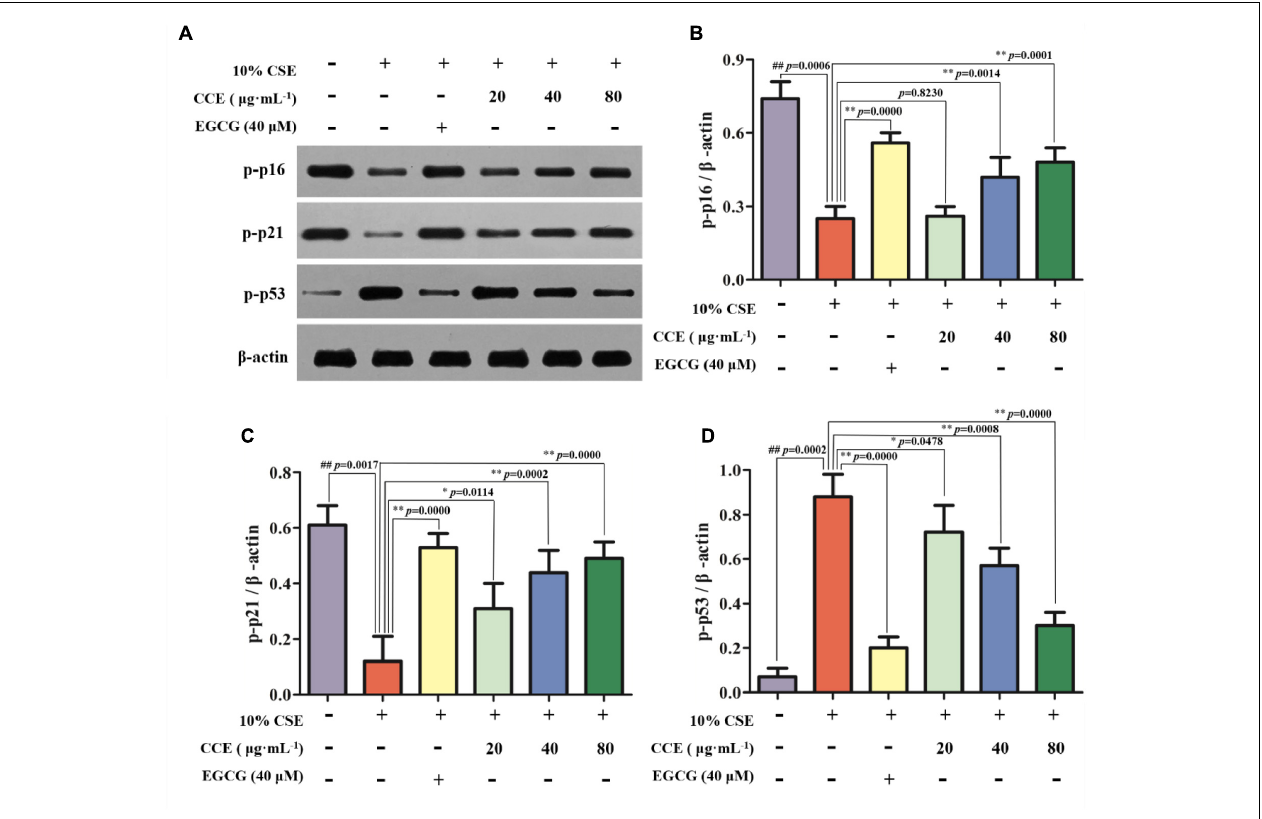
FIGURE 4 | Effects of CCE on the phosphorylation levels of p-p16, p-p21, and p-p53 in 10%CSE-induced NHBE cells. NHBE cells were incubated for 24 h with 10% CSE in the presence or absence of 20, 40, 80 µ g · mL − 1 CCE or 40 µ M EGCG. (A) Protein bands; (B) Effect of CCE on the relative expression of p-p16 protein in NHBE cells; (C) The relative expression of p-p21 protein; (D) p-p35 protein in NHBE cells. Data are expressed as means ± SD ( n = 3). ## p < 0.01, vs. the blank control; ∗ p < 0.05, ∗∗ p < 0.01, vs.